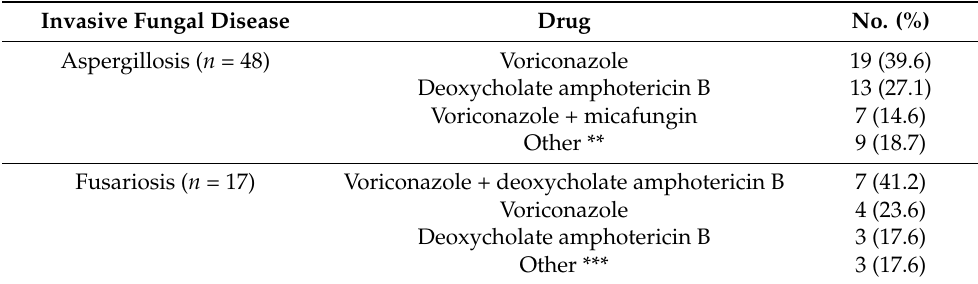
Table 3. Antifungal therapy in 91 episodes of invasive fungal disease *. Invasive Fungal